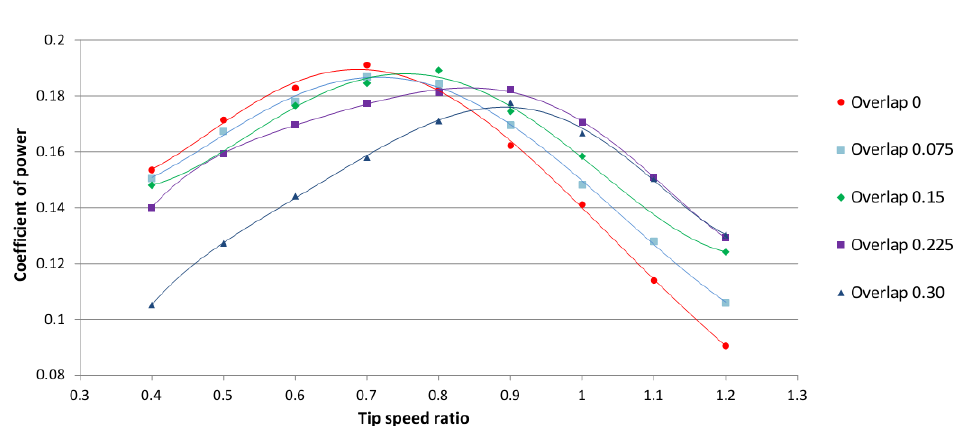
Figure 5: Coefficient of power for the Classical Savonius with different overlap ratios in 2D.